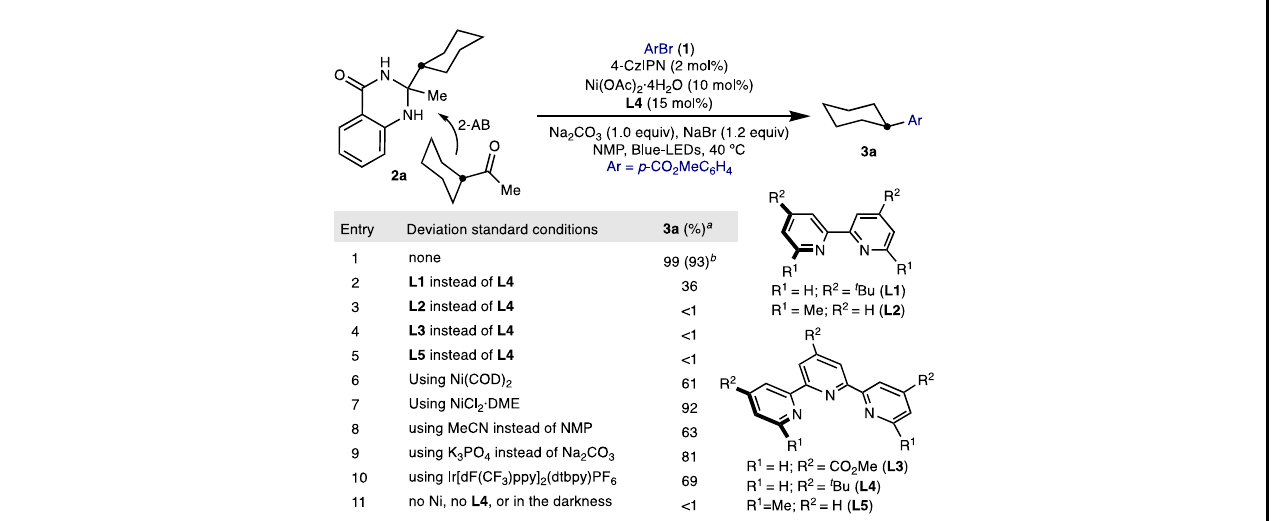
Table 1 Optimization of the reaction conditions.